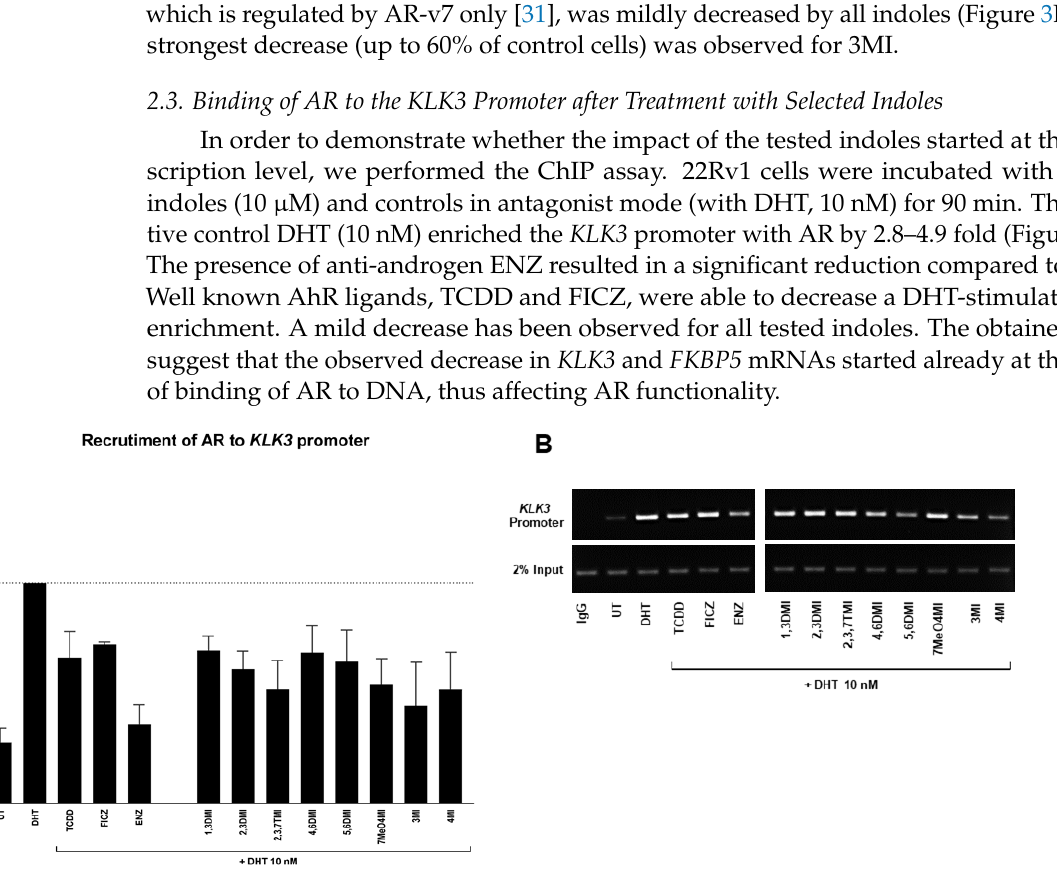
Figure 4. Chromatin immunoprecipitation. 22Rv1 cells were incubated with the tested compounds for 90 min (all indoles, FICZ, and ENZ at 10 µM; DHT and TCDD at 10 nM). Thereafter, the enrichment of the KLK3 promoter with AR was evaluated. The results are expressed as a percentage of positive control. Enrichment of KLK3 promoter by DHT was set to 100% ( A ). Representative DNA fragments were amplified using PCR and analyzed with agarose gel electrophoresis ( B ).